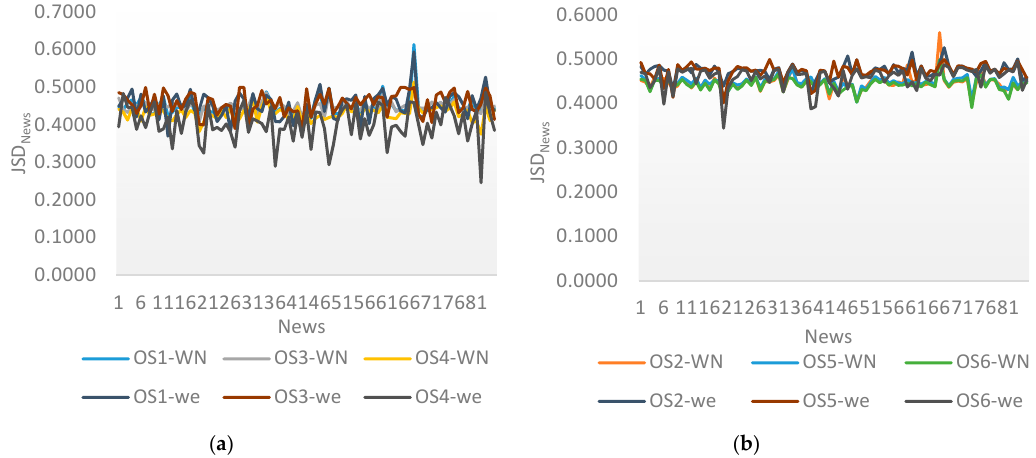
Figure 8. Results of JSD News applying ( a ) term and ( b ) sentence clustering, using WordNet and word embeddings on the COVID-19 dataset.